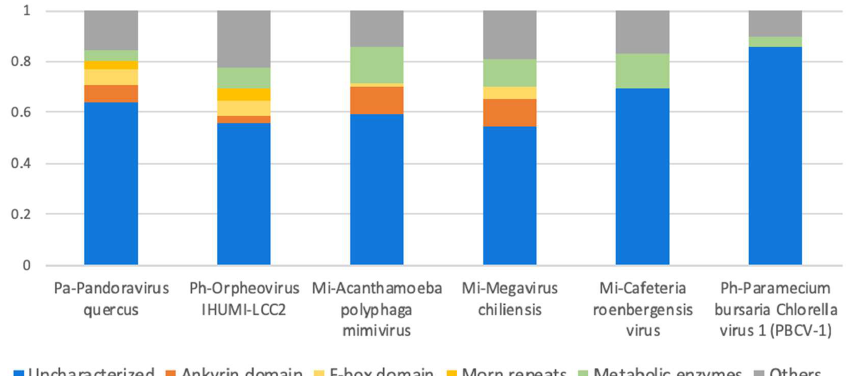
Figure 3. Protein function categories in six giant virus representatives from three families: Mimiviridae (Mi), Pandoviridae (Pa) and Phycodnaviridae (Ph). In all proteomes, the majority of proteins are uncharacterized. Short repeated domains such as ankyrin, F-box and MORM repeats are abundant in the proteomes of amebae-infecting giant viruses [71].